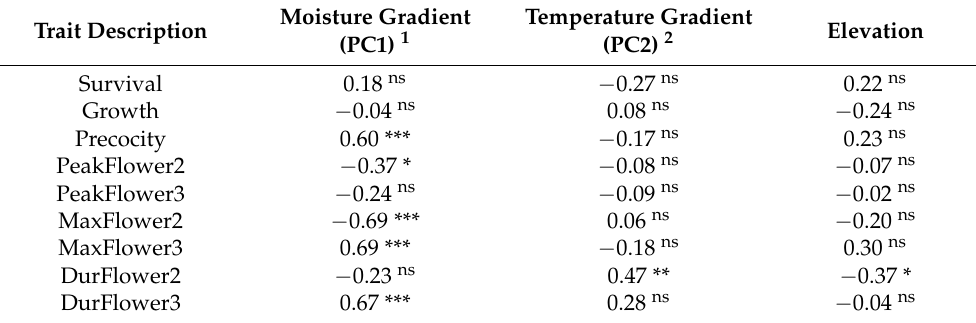
Table 4. Correlation of population level BLUPs with PC1, PC2, and elevation, for Leptospermum scoparium traits. Moisture Trait Description